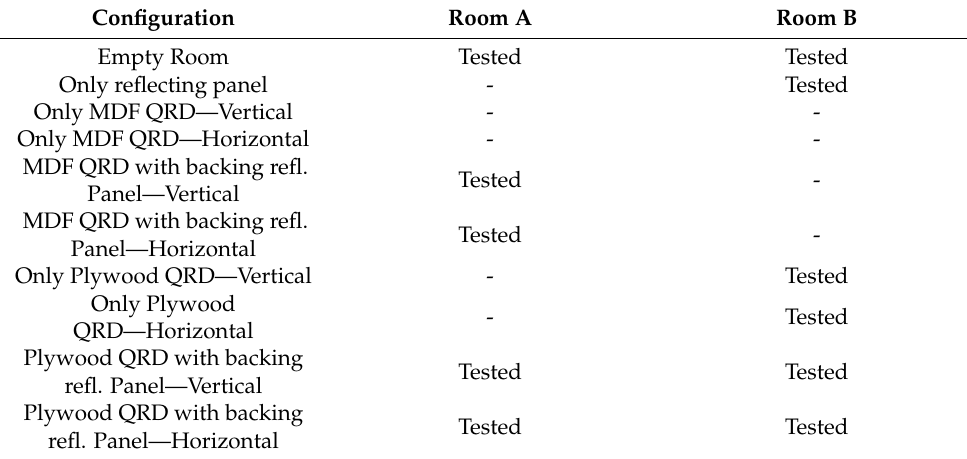
Table 1. Test performance organized in Room A and B.